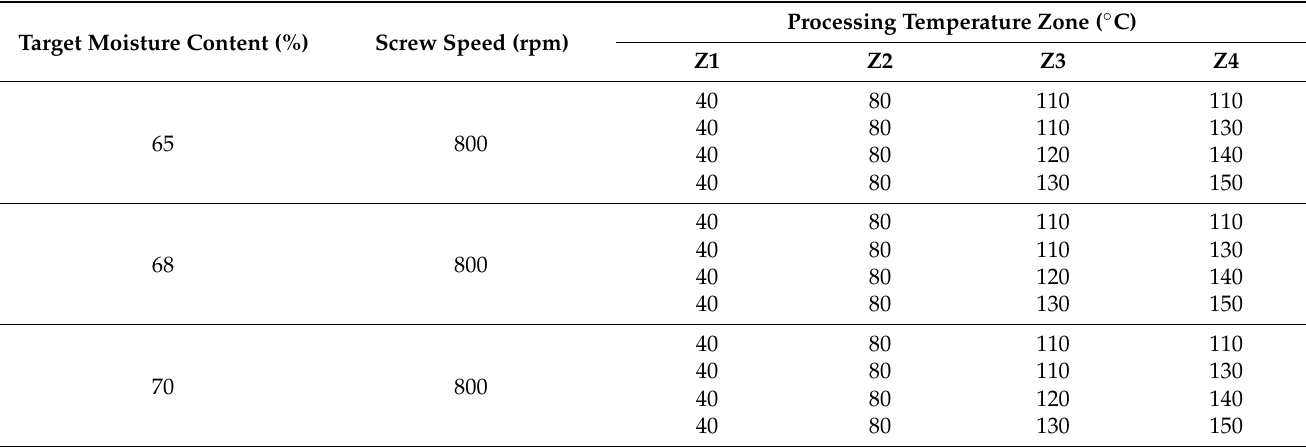
Table A1. Extrusion parameters tested during preliminary trials with commercial yellow pea protein isolate (total mass flow 3 kg/h) to determine the temperature range in extrusion barrel zones 1–4 (Z1–Z4) to be used in experiments.